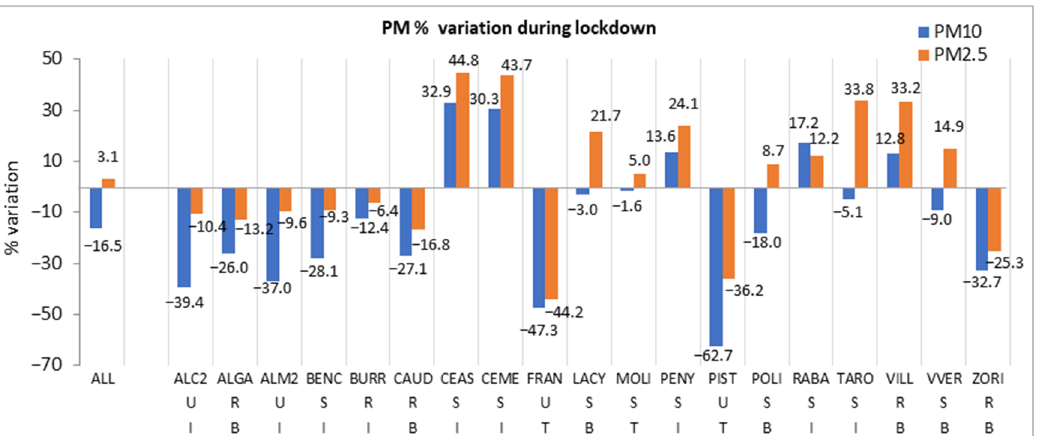
Figure 2. Percentage variation of PM 10 and PM 2.5 for each station. Codes below ACQ names refer to their type of environment, U: urban, S: suburban, R: rural; and type of environment, T: traffic, I: industrial, B: background.